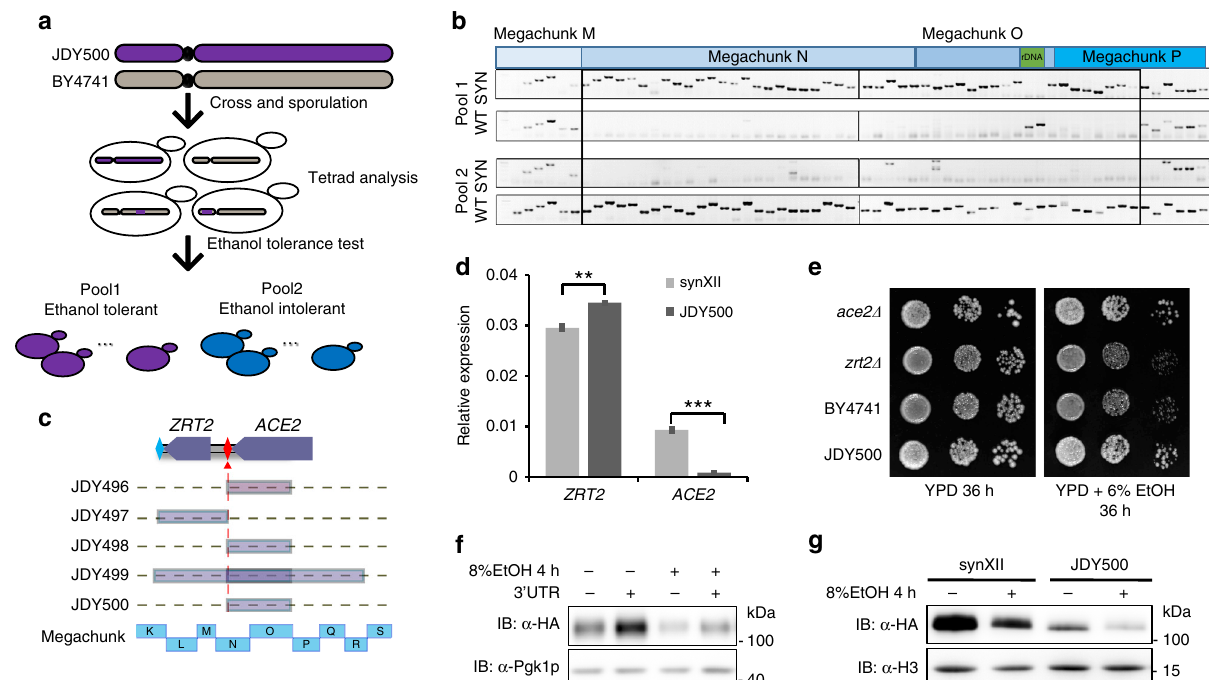
Fig. 4 Dissect the mechanism of ethanol tolerance. a Schematic illustration of procedures to segregate spores from backcross. JDY500 and BY4741 were crossed and sporulated. Tetrads were dissected and tested for ethanol tolerance. The ethanol-tolerant (Pool 1) or intolerant (Pool 2) spores were collected for PCR analysis. b PCRTag analysis showed that regions of synthetic chromosome (From megachunk M to megachunk P) are associated with ethanol tolerance. c High-throughput sequencing analysis revealed a commonly rearranged junction between ZRT2 and ACE2 among fi ve ethanol tolerant strains. The loxPsym sites presented as red diamond between ZRT2 and ACE2 was the common loxPsym site used for rearrangements in these fi ve strains. The megachunks were used to indicate the relative position of these rearrangements. d Signi fi cant decrease of ACE2 but not ZRT2 mRNA level in JDY500. Cells at log phase were collected for total mRNA extraction. The detected mRNA level (mean ± s.d.) was normalized to actin. Three biological replicates were measured, ** represents a P -value < 0.05 using two-tailed student t -test, *** represents a P -value < 0.01 using two-tailed student t -test. e Deletion of ACE2 but not ZRT2 generated ethanol tolerant phenotype. Cells at log phase were series diluted and spotted onto YPD medium or YPD medium with 6% ethanol. f The 3 ′ UTR is important for Ace2p protein expression. ACE2 with or without the 3 ′ UTR was cloned into a centromeric plasmid under the control of TEF1 promoter and tagged with 3xHA at N-terminus. The plasmids were transformed into BY4741. Expression of Ace2p was determined by immunoblotting. Pgk1p was used as the loading control. g Measure Ace2p expression in JDY500 and synXII. The endogenous Ace2p was tagged with HA and TEF1 promoter. Expression of Ace2p was determined by immunoblotting. Histone H3 was used as loading